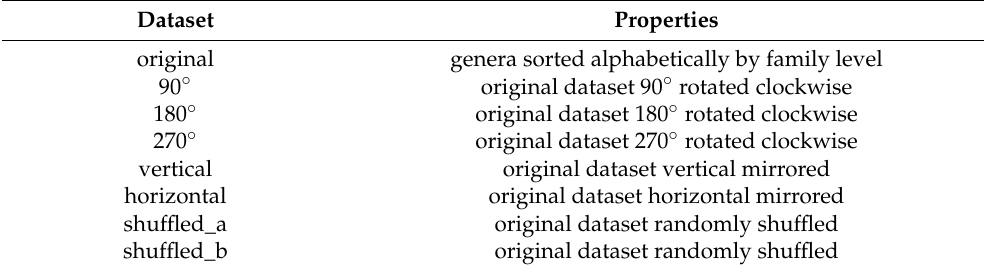
Table 2. Modifications of original dataset.